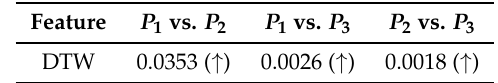
Table 2. p -Values related to pairwise statistical analysis of the DTW (dynamic time warping) values, as estimated between human and horse, during the different phases ( P 1 , P 2 , P 3 ).